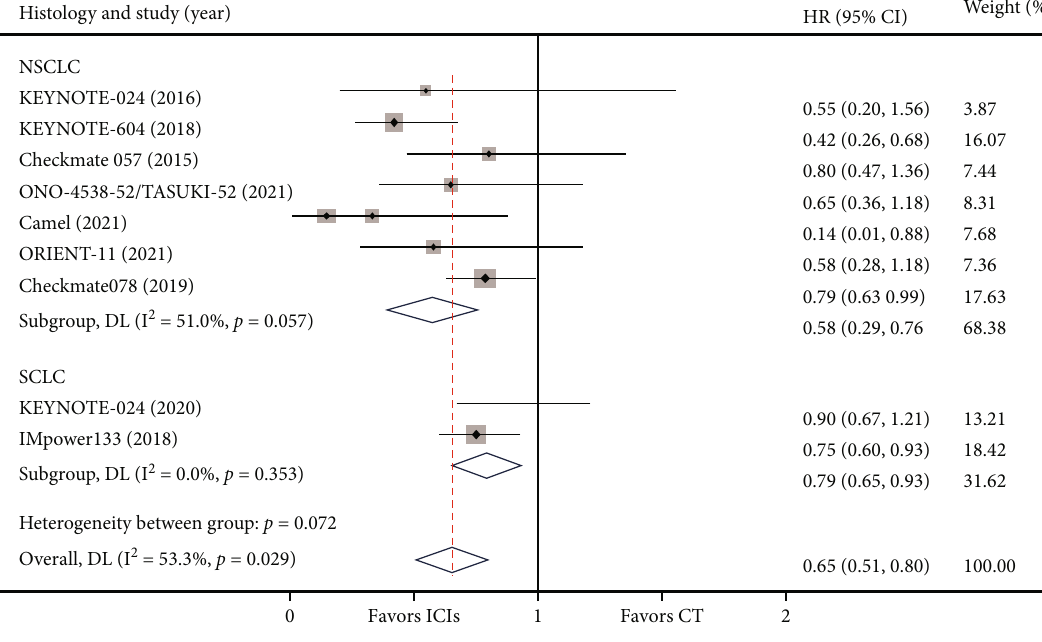
Figure 6: Subgroup analyses of PFS by histology between the immune checkpoint inhibitors (ICIs) group and the chemotherapy (CT) group for lung cancer with